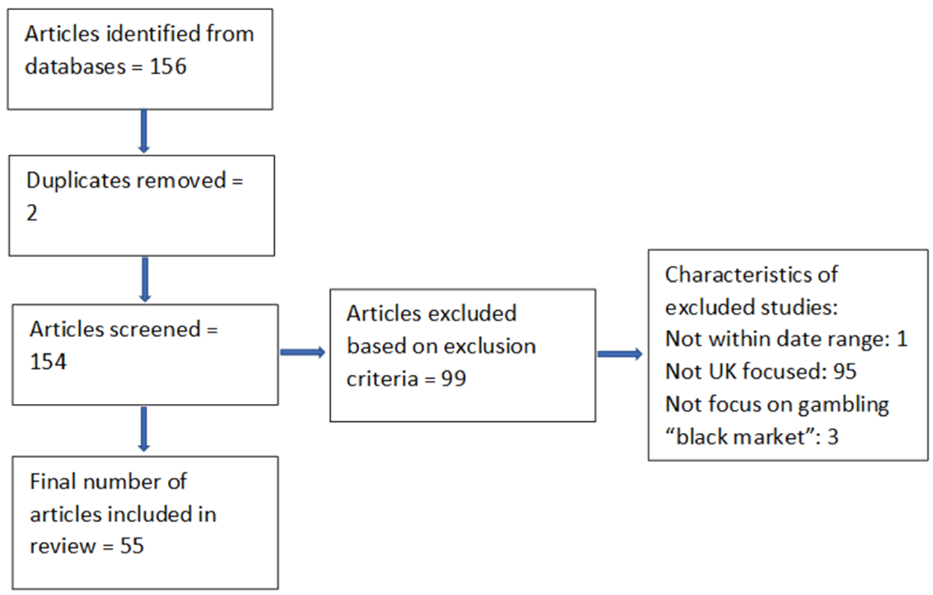
Figure 2. Search process and results.